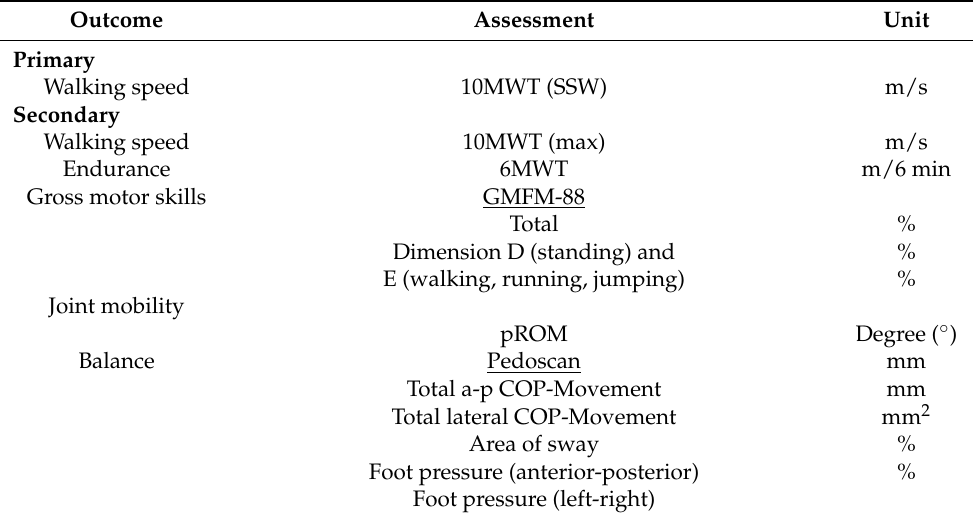
Table 2. Primary and secondary